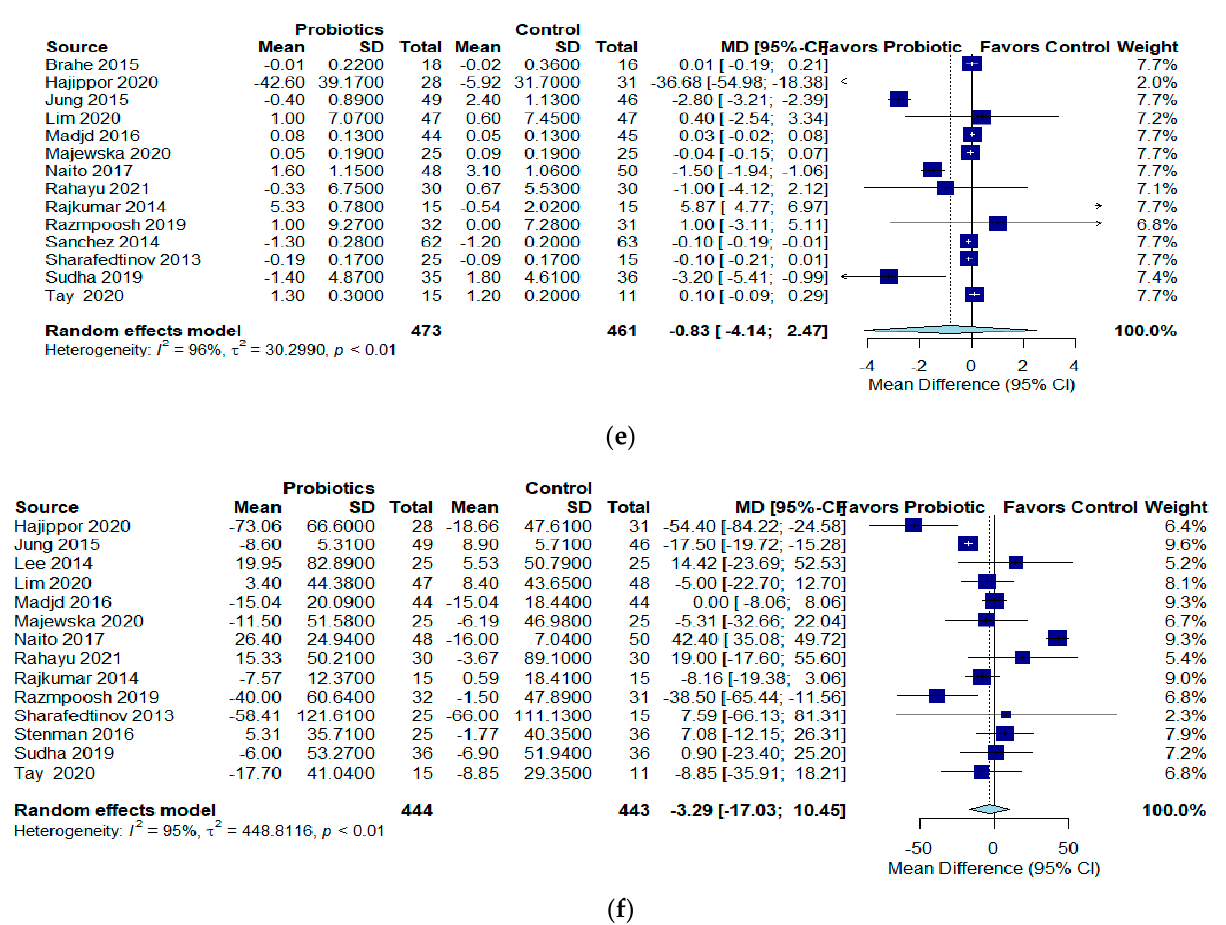
Figure 3. Effects of probiotics on: ( a ) SBP in mmHg; ( b ) DBP in mmHg; ( c ) glucose (mg/dL); ( d ) LDL (mg/dL); ( e ) HDL (mg/dL); and ( f ) triglycerides (mg/dL).